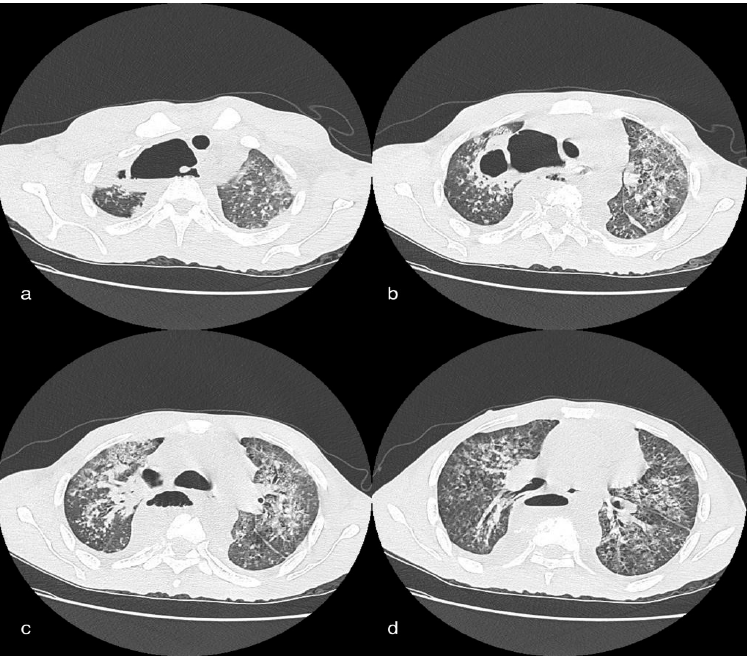
Figure 7. Female patient, 26 years old, of African descent in whom there is ample cavitation of two pre- and paravertebral abscess collections of the dorsal tract. The cranial collection ( a , b ) extends from D2 to D5 and leads to compression of the contiguous lung parenchyma, to the apical segment of the LSD, and compresses and latero-deflects the trachea to the left. From this collection, the air-borne component is also carried cranially into the right cervical prevertebral space ( b ). Another collection ( c , d ), with the same characteristics and with an extended aerial component, can be seen in the prevertebral space between space between D5 and D10. Evidence of an airway between the two collections at D5.